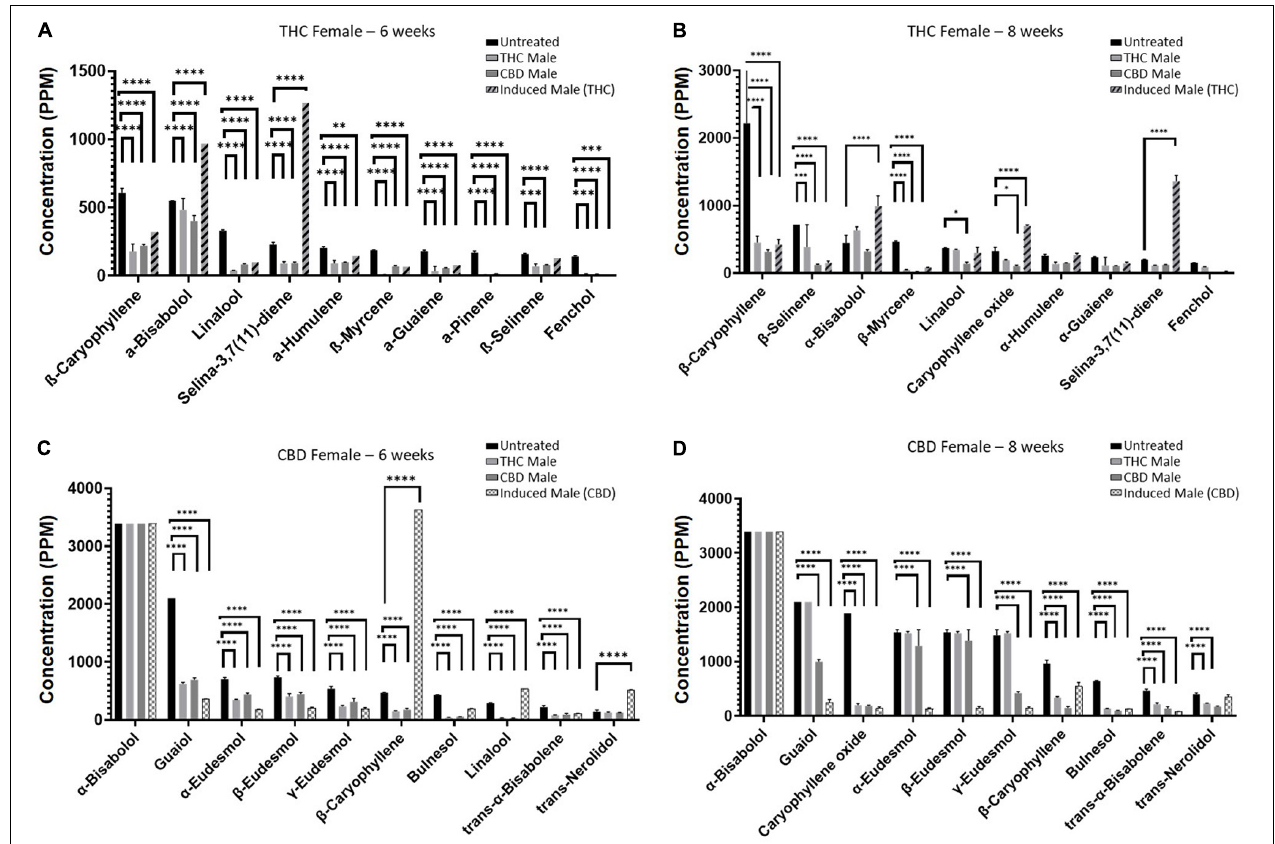
FIGURE 5 | Individual terpenoid concentrations in THC- and CBD-rich female plants at 6 or 8 weeks. Abundant terpenoids in the unfertilized female flowers and their concentrations at 6 weeks (A,C) and 8 weeks (B,D) . Data are reported as mean ± SEM of terpenoid concentration ( n = 2–3, except THC-female fertilized by induced male (THC) at 6 weeks). Statistically significant differences between treatments and control (unfertilized) were calculated by two-way ANOVA followed by Dunnett’s multiple comparison test (* p ≤ 0.05; ** p ≤ 0.01; *** p ≤ 0.001; **** p ≤ 0.0001). Values presented without SEM exceeded the maximal detection limit (maximum limits of detection for terpenoids appear in Supplementary Table 5 ).